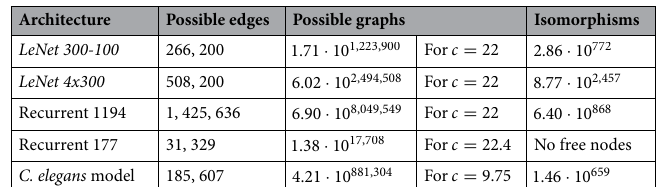
Table 10. Amount of possible edges, unique and isomorphic graphs for the different network